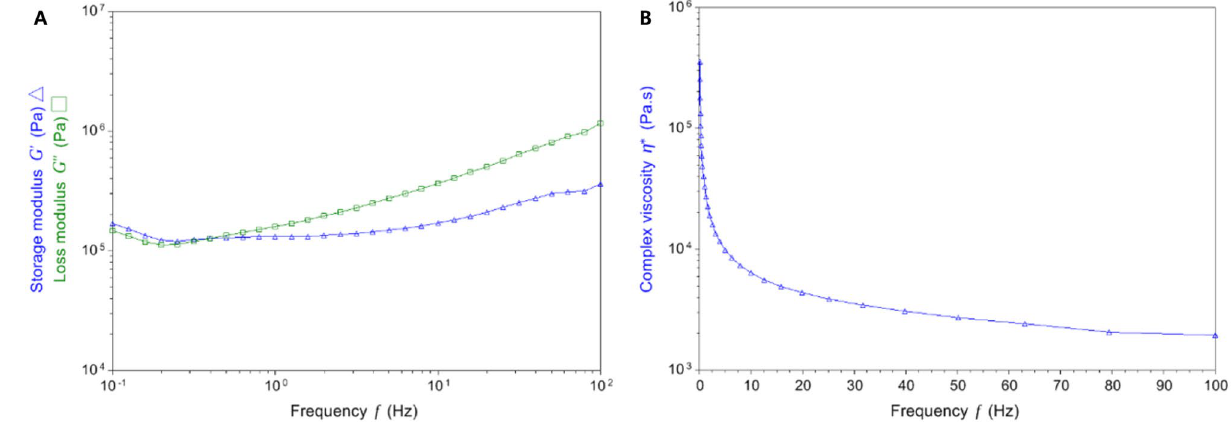
Figure 2. ( A ) Storage modulus G ′ , loss modulus G ″ , and ( B ) complex viscosity η * as a function of